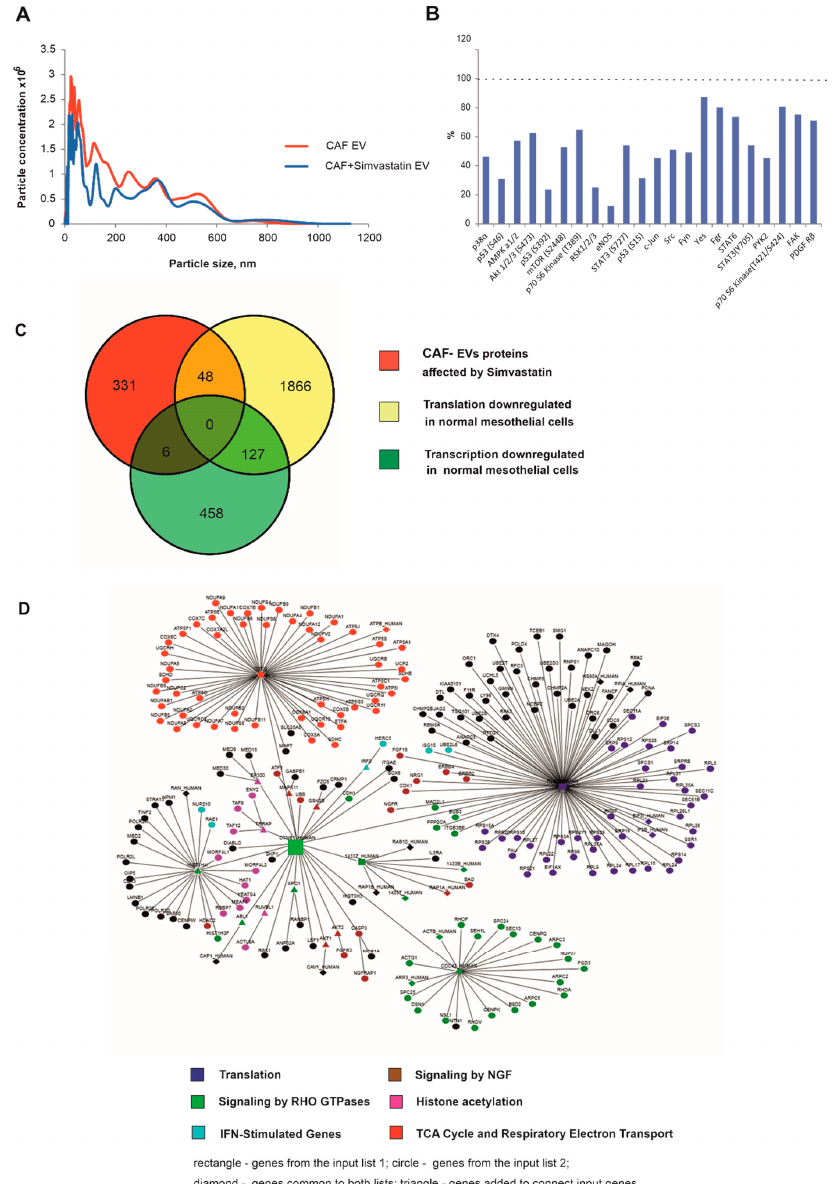
Figure 5. Simvastatin treatment reduces EVs production by CAFs and ameliorates activation of pro-oncogenic signalling pathways in LP-9 cells. ( A ) Representative graph of concentration and size distribution of EVs derived from the same number of untreated CAFs and CAFs treated with 500 nM Simvastatin for 24 h, obtained by nanoparticle tracking analysis (NTA). ( B ) Kinome profiling analysis of LP-9 cells treated with EVs derived from CAFs. Kinase activation in LP-9 cells incubated with EVs derived from Simvastatin-treated CAFs expressed as a percentage of that detected in LP-9 cells incubated with an equal amount of EVs derived from untreated CAFs (set to 100%). ( C ) Venn diagram showing overlap of the genes transcriptionally or translationally downregulated ( p < 0.05) in normal mesothelial cells with the genes encoding proteins affected by Simvastatin treatment. ( D ) The top genes functionally related to the two lists of genes (1st—affected by Simvastatin treatment, 2nd—translationally downregulated in normal mesothelial cells compared to malignant cells) with p < 0.00096, Catenin beta 1 (CTNNB1), forms a network related to translation, mitochondrial function, chromatin remodelling, signalling by RHO GTPases, NGF and Interferon (rectangle—the gene from the input list 1; circle—the gene from the input list 2; diamond—the gene common to both lists; triangle—genes added to connect input